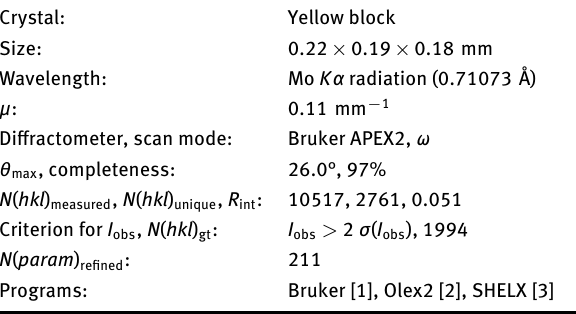
Table 1: Data collection and